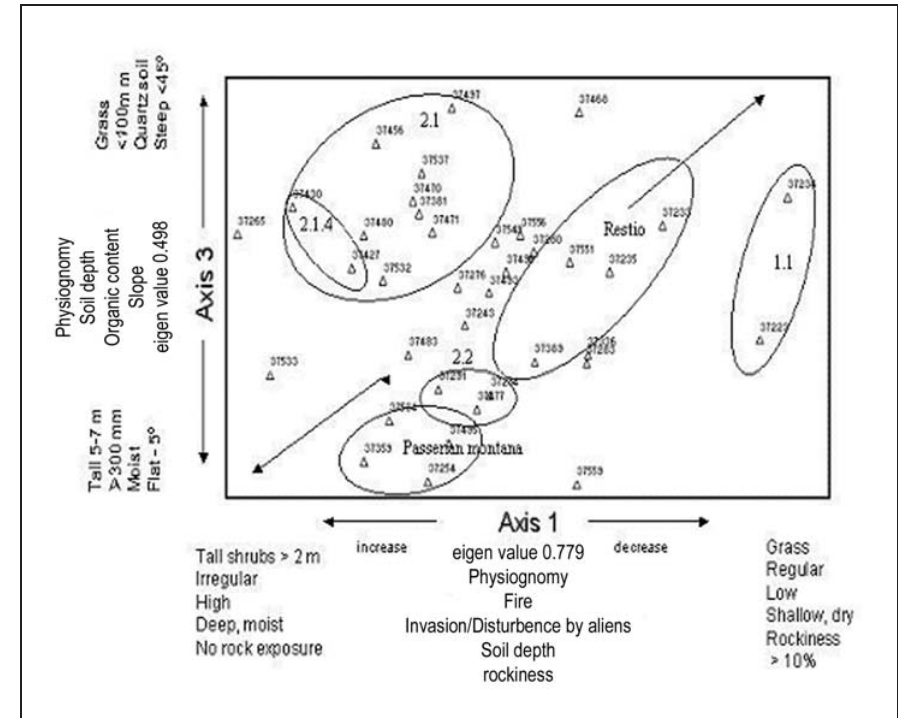
FIGURE 3 DECORANA ordination of the fynbos communities of